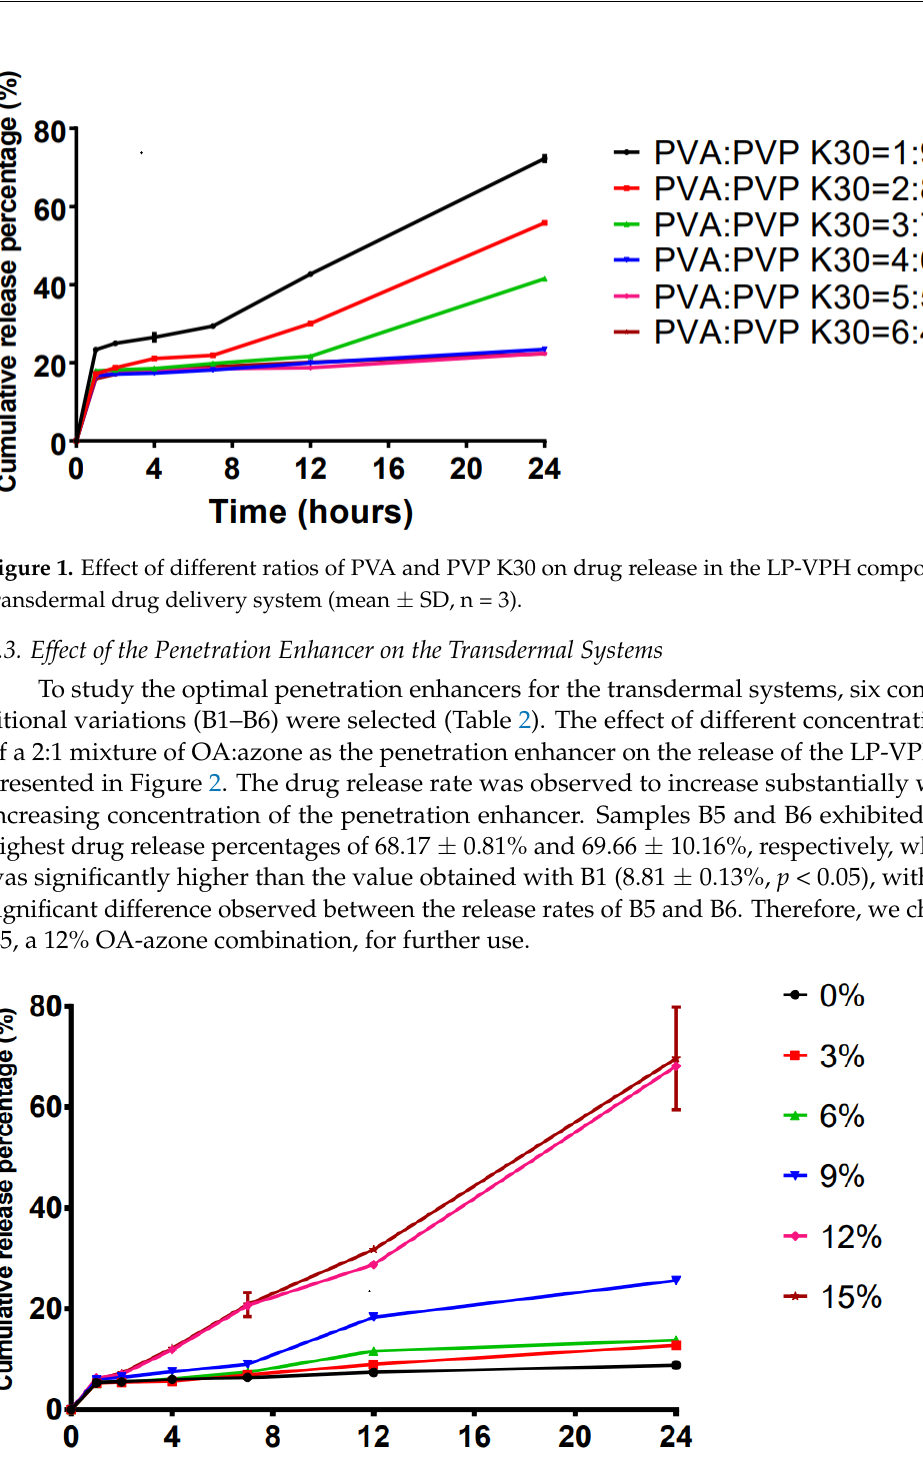
Table 2. Formulation of LP-VPH compound transdermal drug delivery system. Formulation